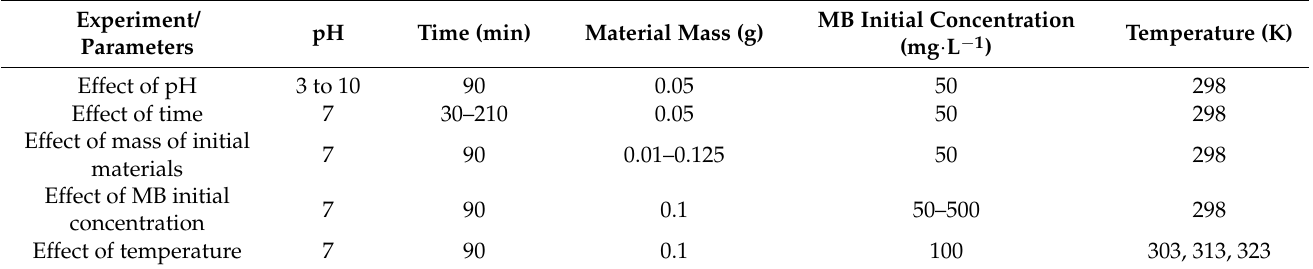
Table 1. Parameters in the